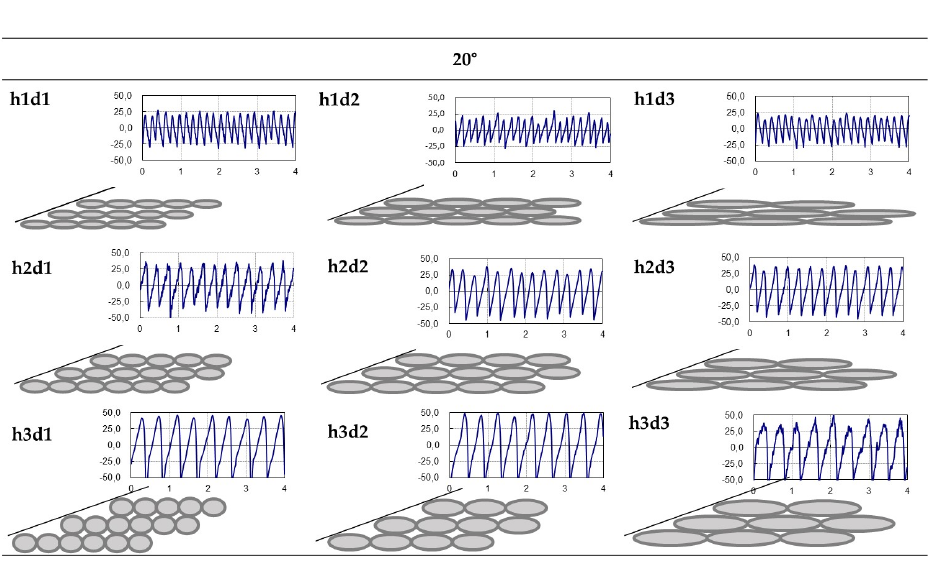
Figure 10. Theoretical (gray) and real (blue) profiles of the whole set of 20° specimens.